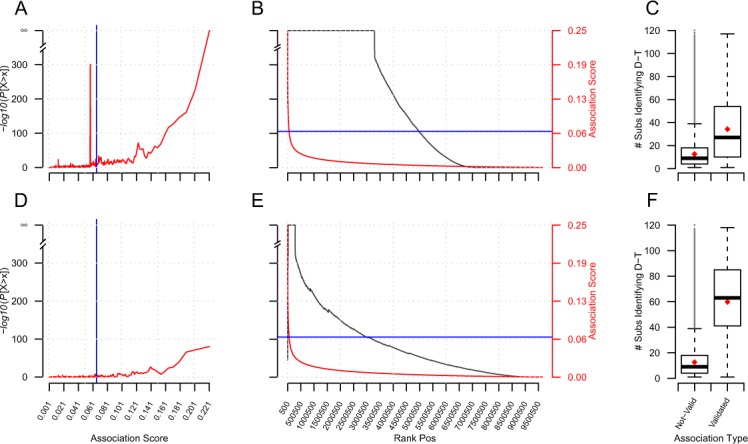
Validation of inferred D-T associations with known D-T associations from DBv3 and DBv4.2.(A, B and C) show how DReSMin identifies and ranks the 2,919 known interactions from DBv3 when searching Dat. (D, E and F) show how DReSMin identifies and ranks the 333 known interactions from DBv4.2. For (A and D) hypergeometric distribution of inferred knowns were calculated using the scores of the validated associations. For (B and E) hypergeometric distribution of inferred knowns were calculated using the ranked position of the validated interactions. (C and F) show the number of semantic subgraphs that inferred knowns in comparison to the number of semantic subgraphs that inferred novel interactions. Note: Blue line shows the highest scoring semantic subgraph; all scores above this line are definitely inferred by > one semantic subgraph.